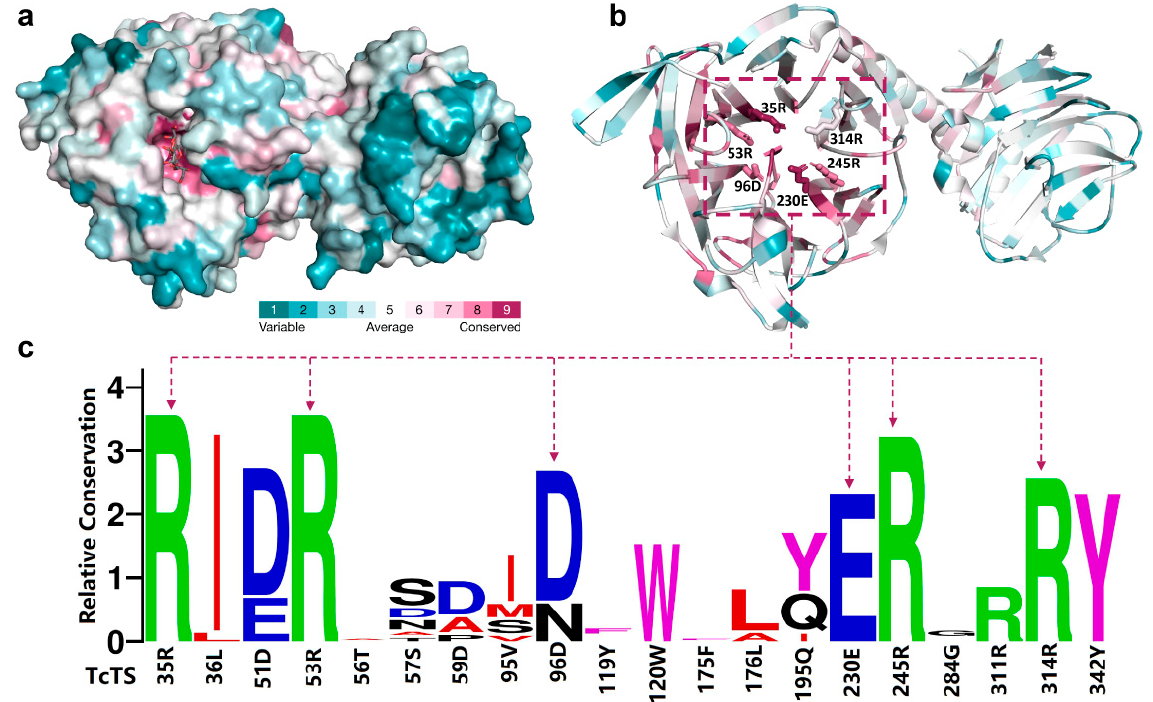
Figure 6. Conserved analysis of GH33 sialidases. ( a ) Conservation analysis of GH33 sialidases. The gradient color spectrum from green to red represents the increase in conservation ( b ) The key functional residues in TcTS. ( c ) Active site sequence profiles of GH33 sialidases. The ordinate indicates the relative degree of conservation, while the abscissa represents amino acid ID of TcTS. Each type of amino acid is represented by abbreviated letters with a corresponding color (KRH: green; DE: blue; MVALI: red; FWY: purple; Others: black), where the same color suggests a similar property of the amino acid. In each row of sequence profiles, the heights of all letters represent the relative degrees of conservation, while the height of a single letter denotes its specific occurrence frequency.